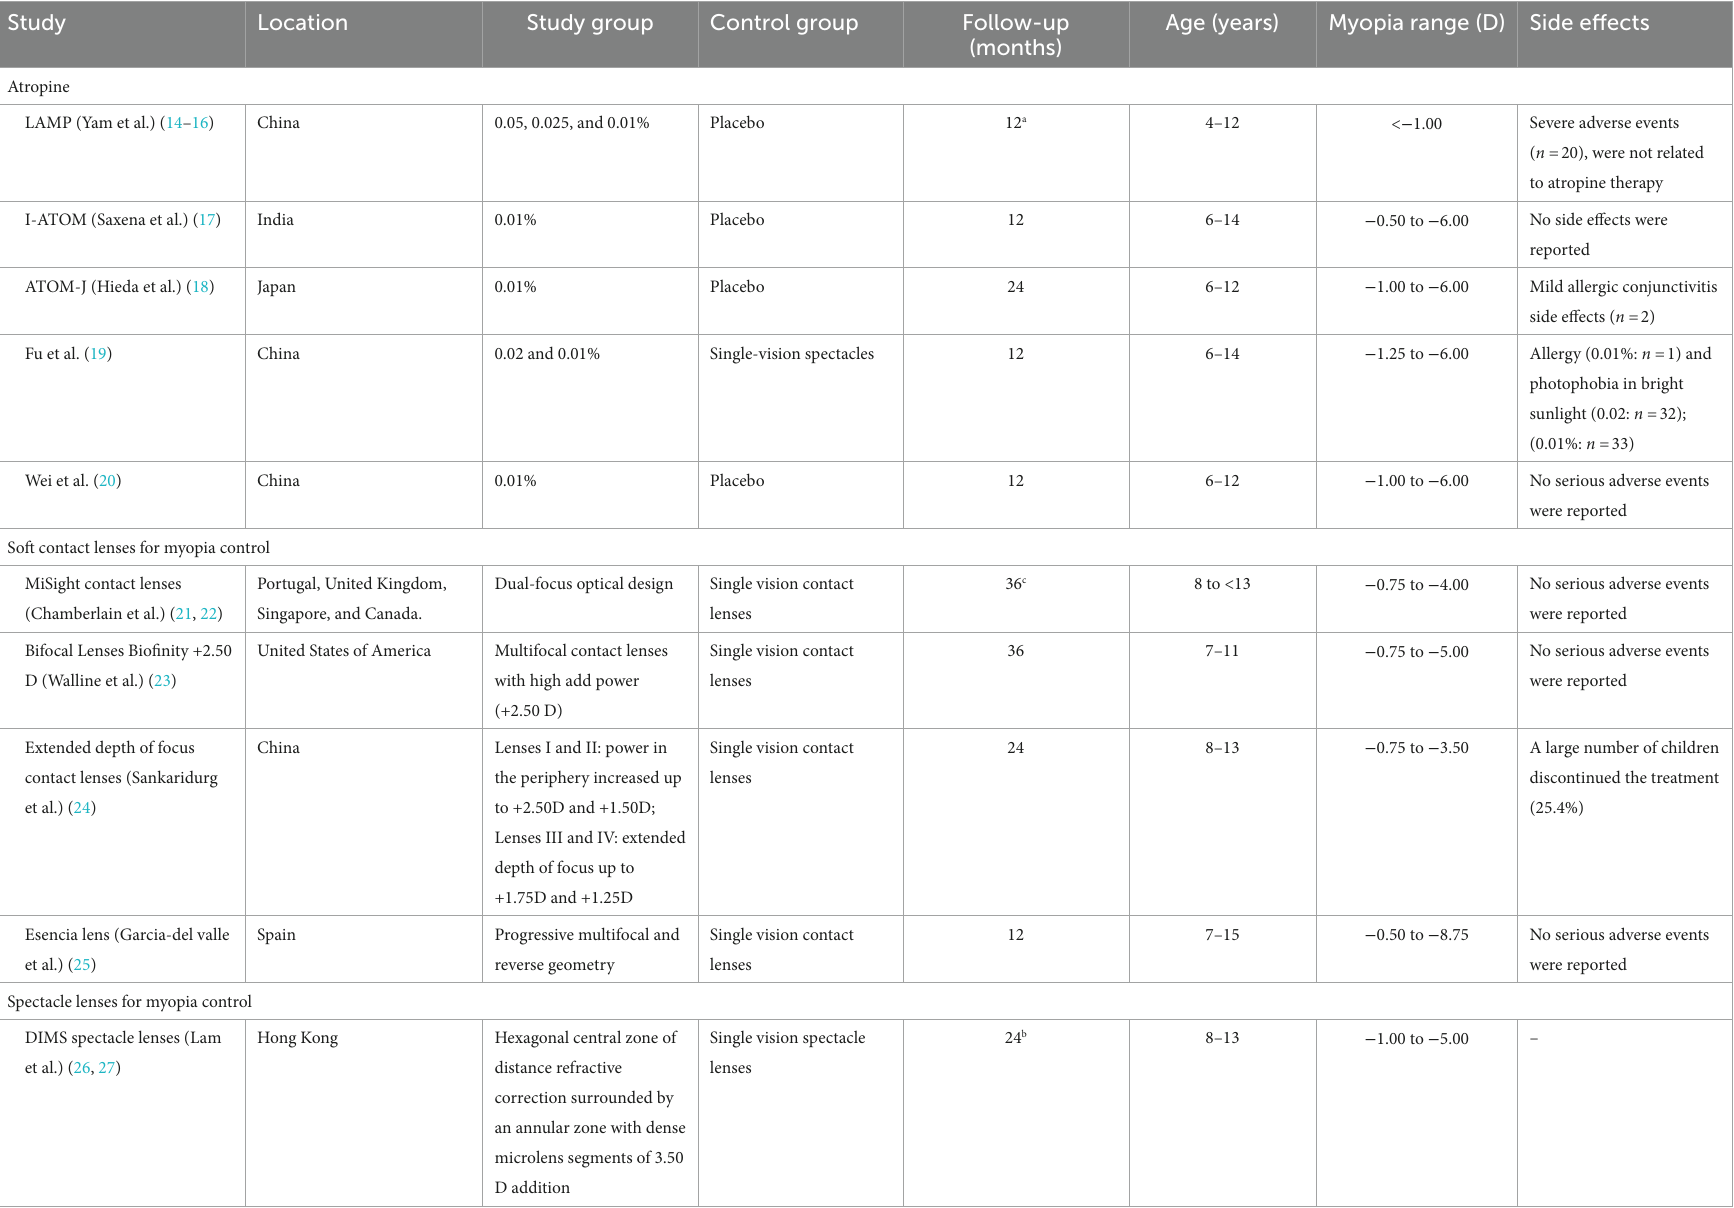
TABLE 1 Characteristics of RCTs included in the review ( n =